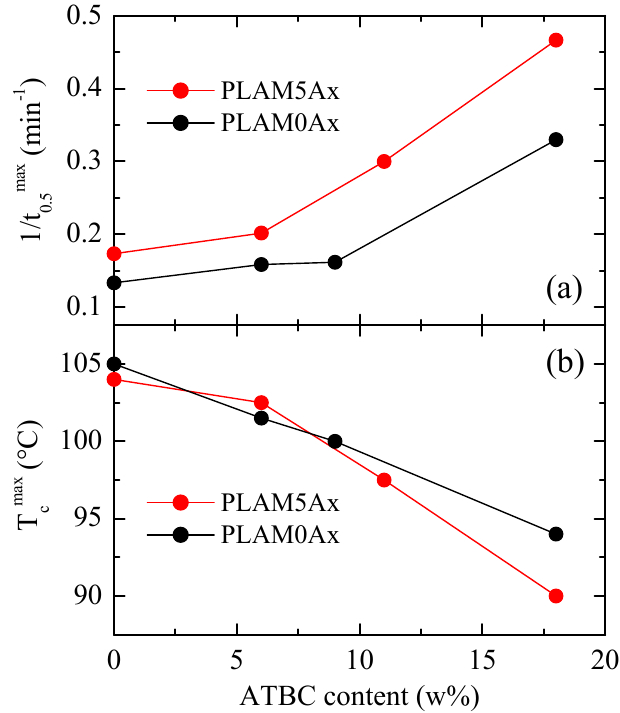
Figure 8. Dependence on the ATBC content in the materials of the maximum rate coordinates in the isotherms from the melt for the two series of samples: ( a ) inverse half crystallization time and ( b ) crystallization temperature at the maximum.